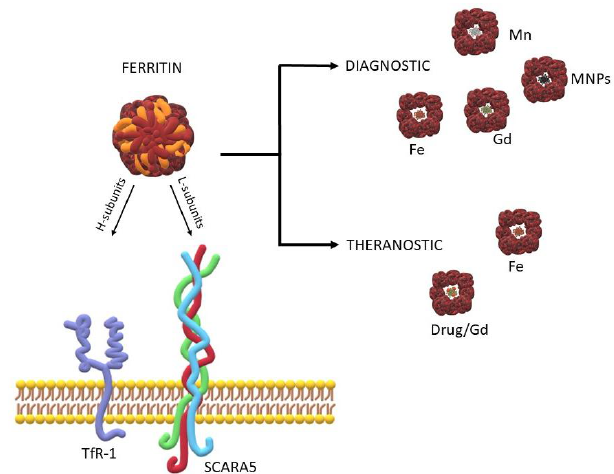
Figure 1. Schematic representation of the use of ferritin for diagnostic and theranostic purposes. The protein cage can be loaded with magnetic resonance imaging (MRI) contrast agents containing paramagnetic ions (Gd, Fe, Mn), magnetic nanoparticles (MNPs) and drugs. Human transferrin receptor 1 (TfR-1) and human scavenger receptor class A member 5 (SCARA5) are the natural ferritin cell-surface receptors for H- and L-ferritin subunits, respectively.